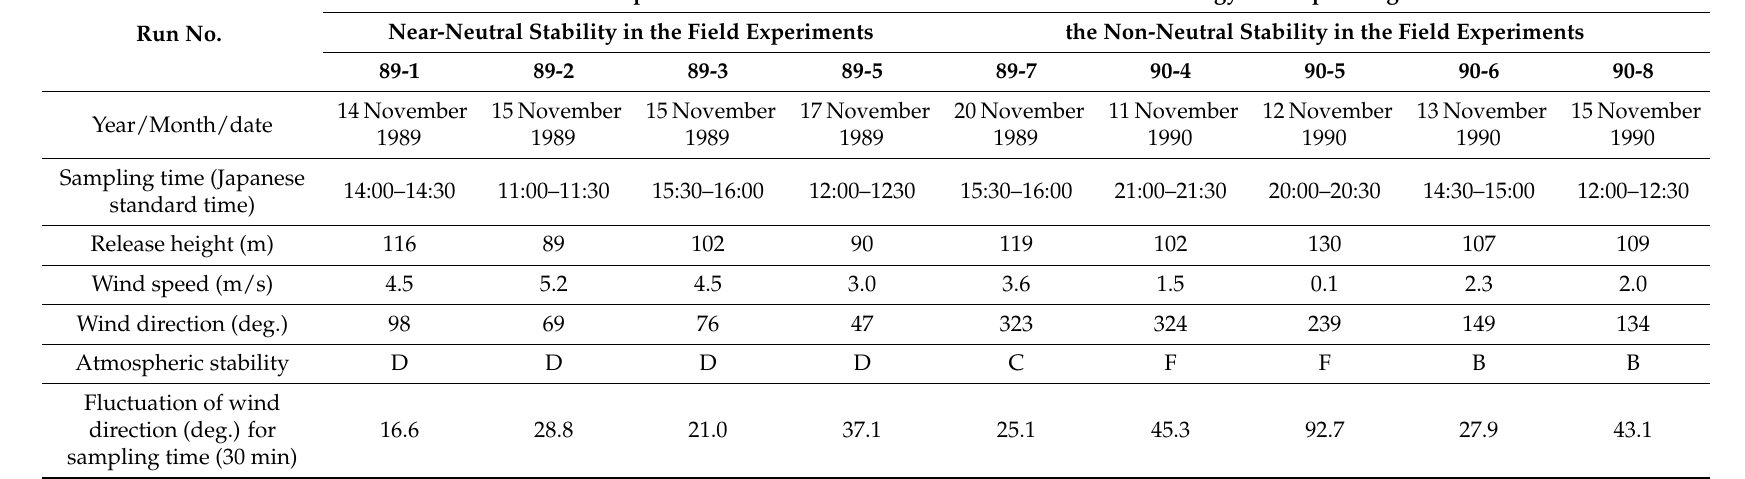
Table 1. Experimental conditions for the gas release and meteorology corresponding to the near-neutral and the non-neutral stabilities in the field experiments [4]. Experimental Condition for the Gas Release and Meteorology Corresponding to Near-Neutral Stability in the Field Experiments Run No.